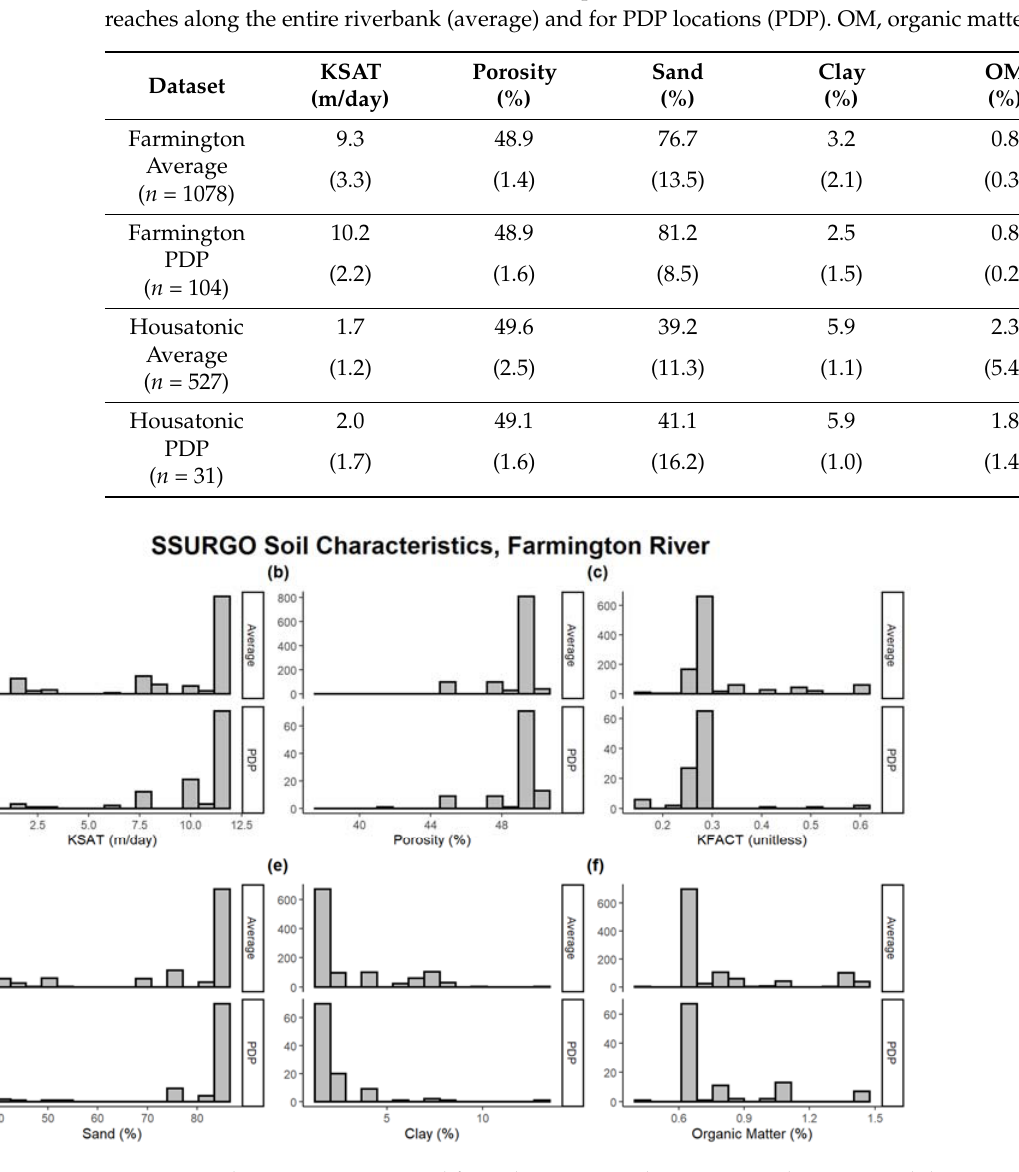
Figure 5. Soil parameters extracted from the SSURGO dataset at PDP locations and the average bank soil parameters from both banks of the Farmington River reach for ( a ) KSAT, ( b ) porosity, ( c ) hydraulic conductivity factor (KFACT), ( d ) sand %, ( e ) clay %, and ( f ) organic matter %.